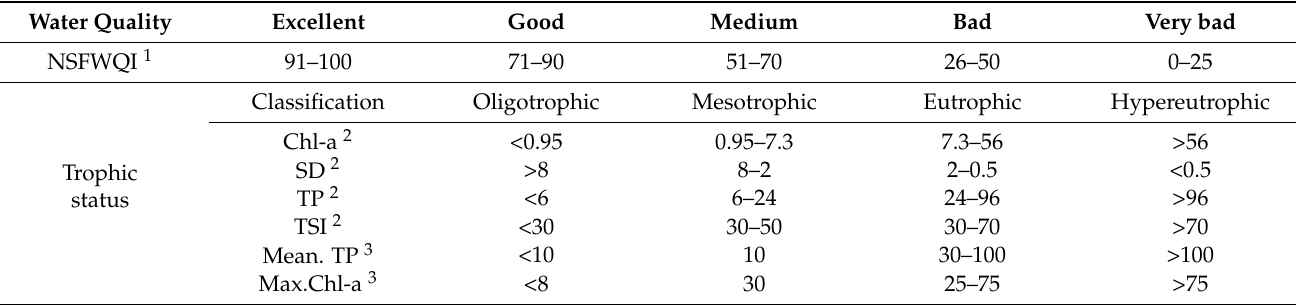
Table 1. Water quality and trophic